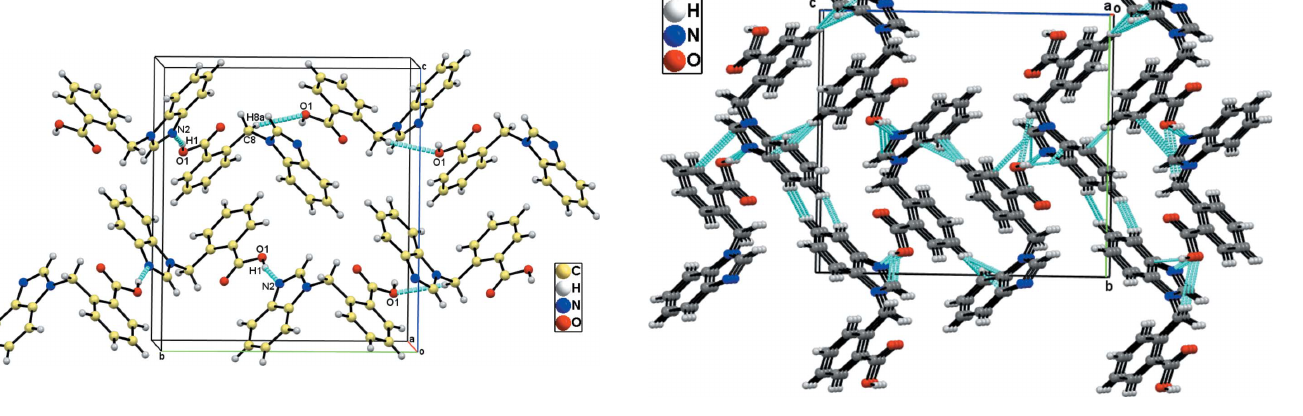
Figure 3 The hydrogen bonding and C—H (cid:3)(cid:3)(cid:3) (cid:2) and (cid:2) – (cid:2) interactions form zigzag chains, giving a supramolecular structure along the bc plane.